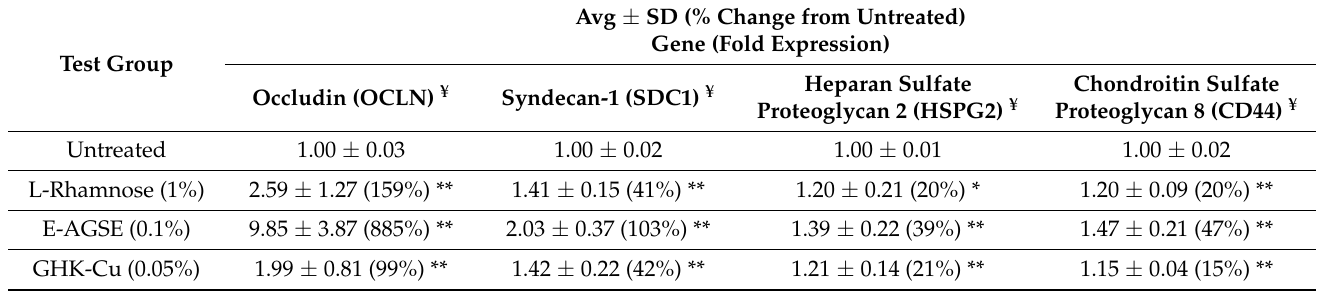
Table 3. Results for marker expression.